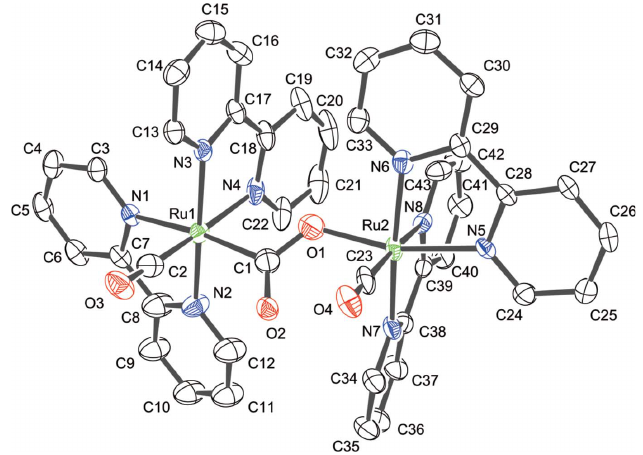
Figure 1 The molecular structure of the complex cation in the title compound, with atom labels and displacement ellipsoids for non-H atoms drawn at the 50% probability